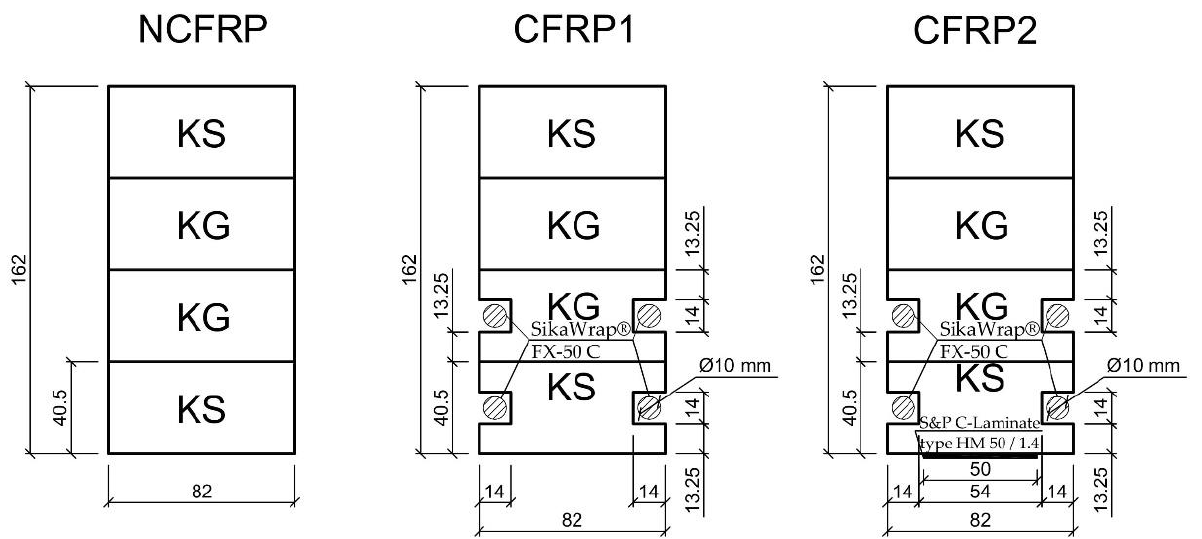
Figure 1. Cross-section of the laminated beams.